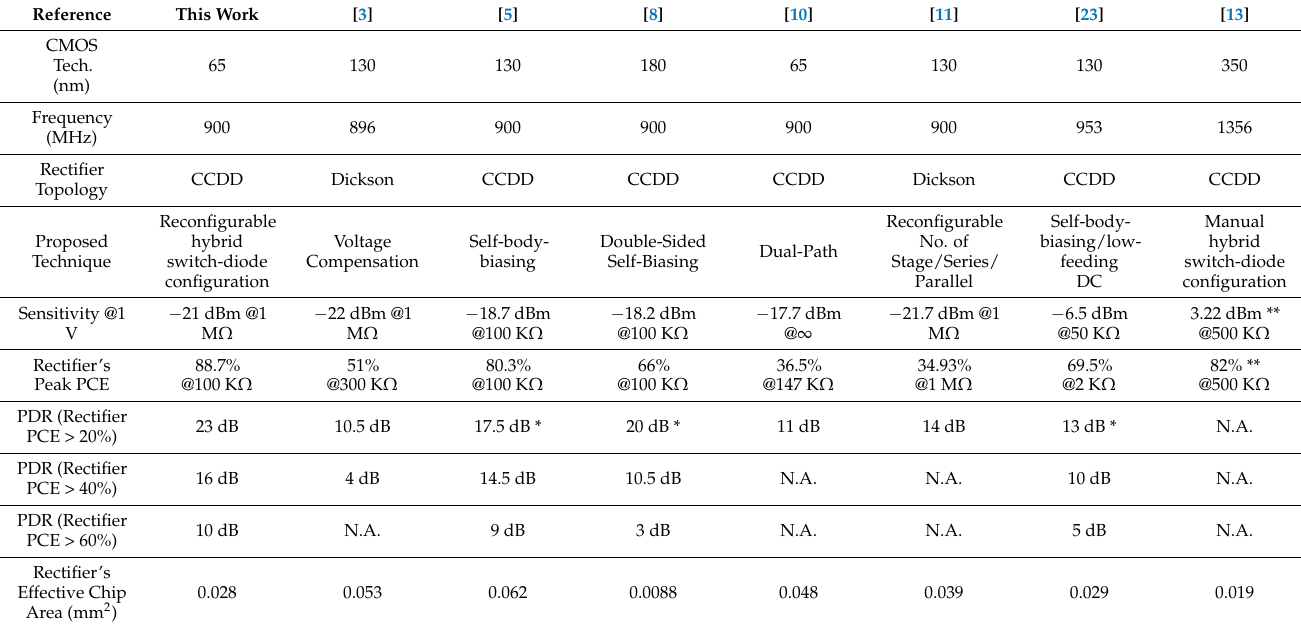
Table 2. Performance benchmark with related State-of-the-art RFEH